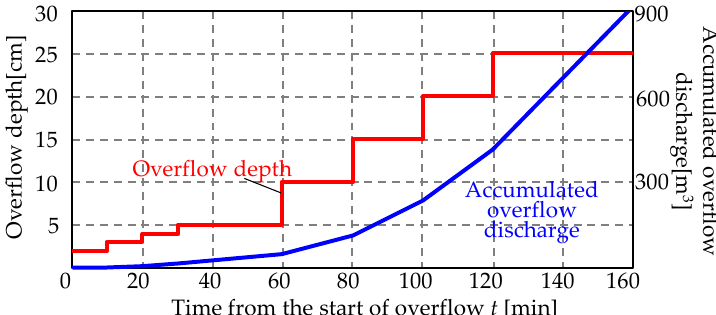
Figure 5. Time series of overflow depth in the tests for model levees with scour protection.